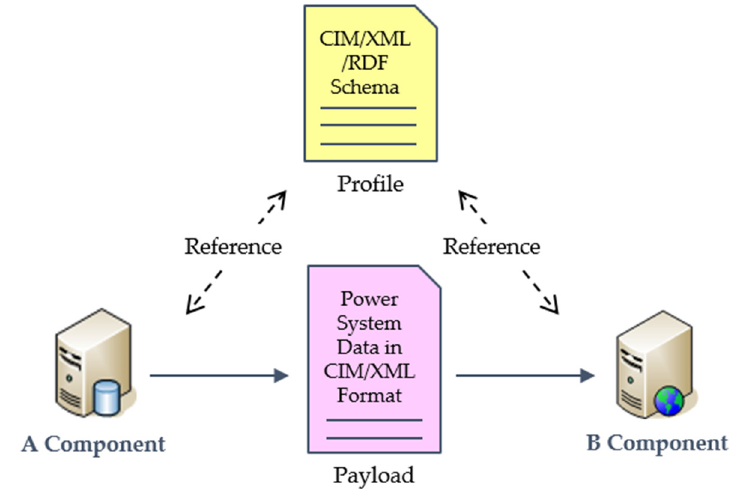
Figure 10. CIM-based data transfer process between two different components.